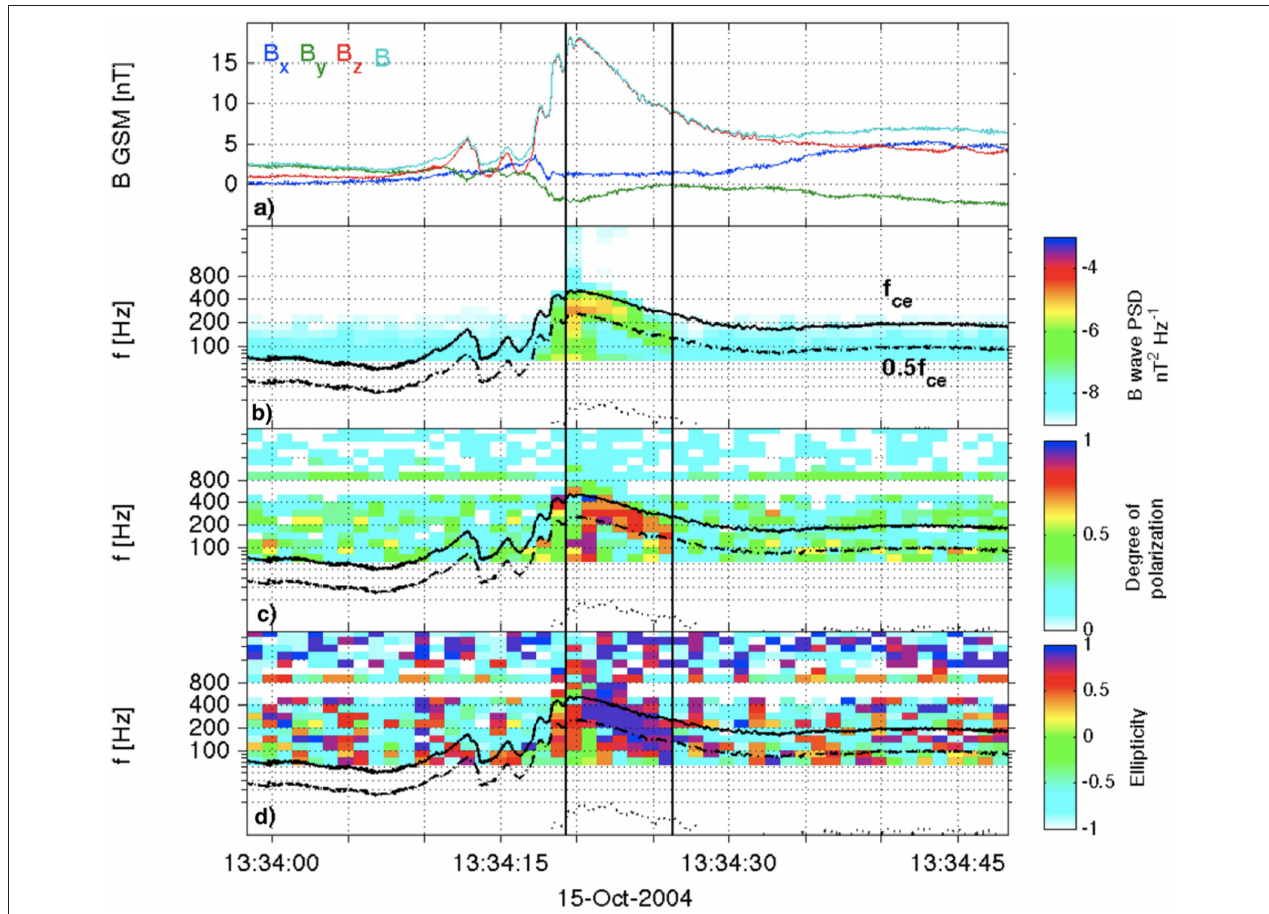
FIGURE 6 | Example of whistler waves observed in the flux pileup region (FPR) at the front of a reconnection jet. (a) Magnetic field with clear increase in B Z (FPR) characteristic for FPR ( Sitnov et al., 2019). (b–d) Show power spectrum of magnetic fluctuations, degree of polarization and ellipticity all of which are enhanced in association with a whistler wave burst between 0.5 and 1 f ce . Adapted from Viberg et al.